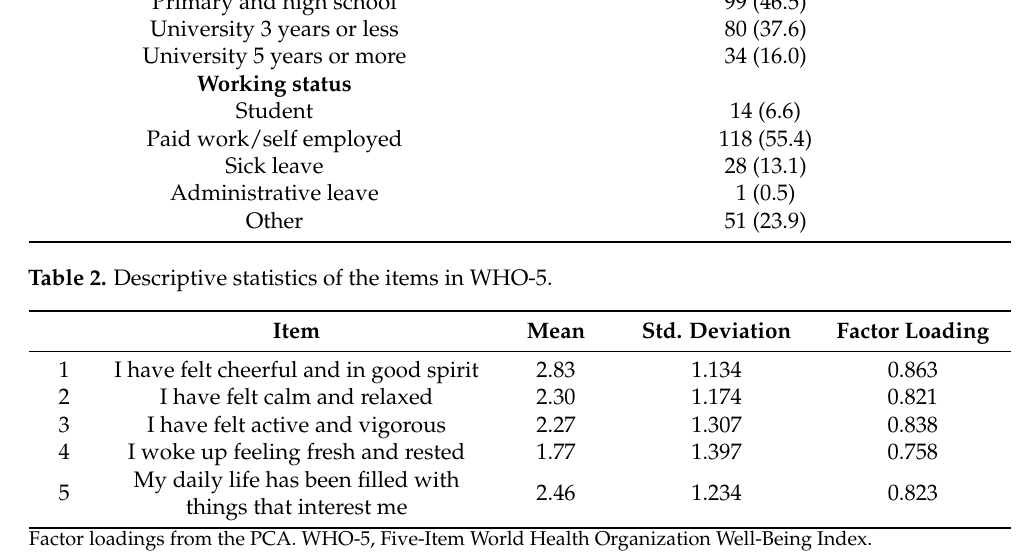
Table 3. Summarizing the hypothesis